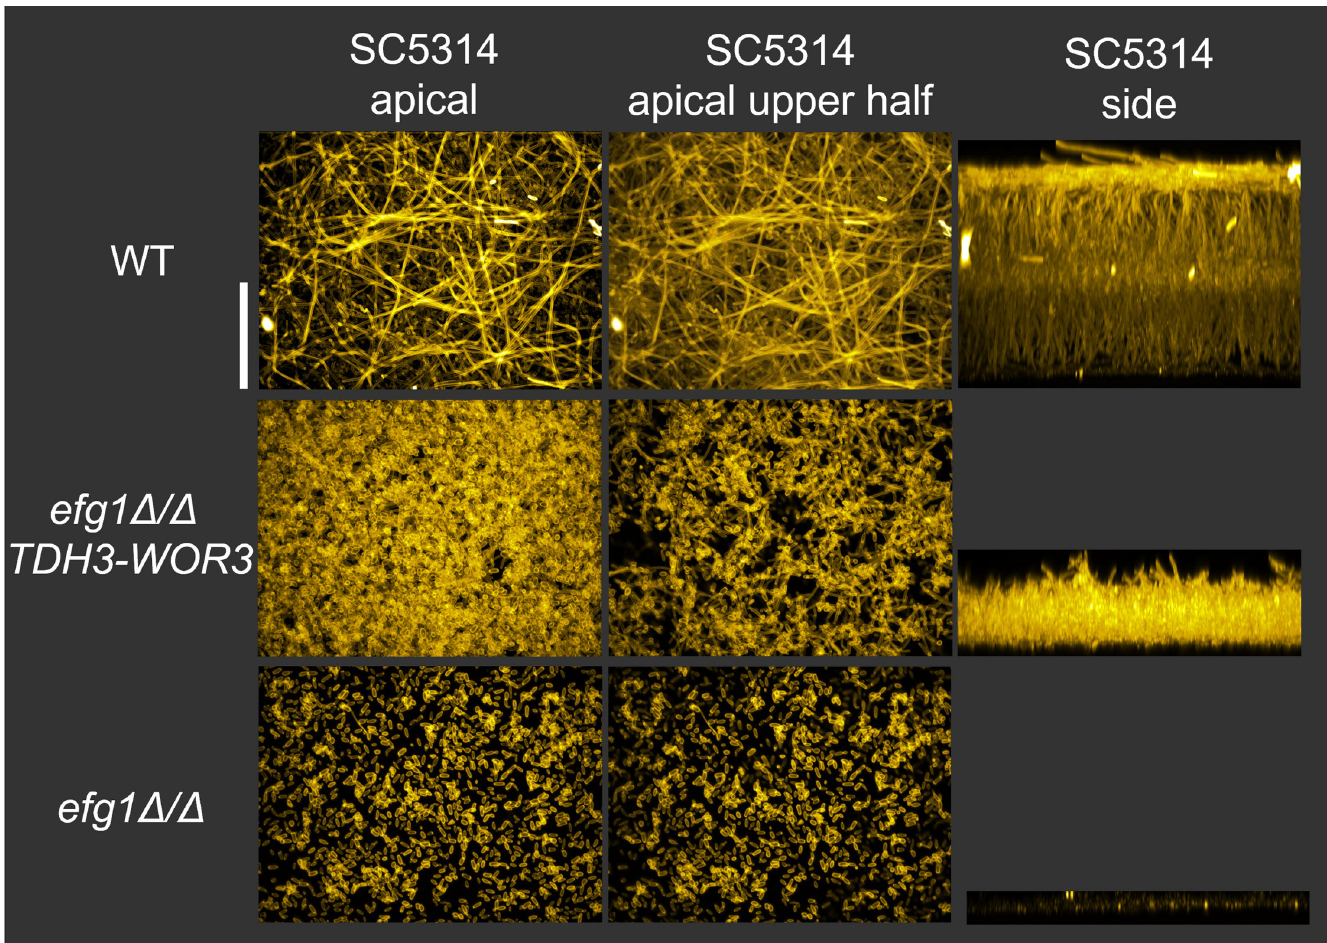
Fig 7. Imaging of TDH3-WOR3 biofilms in the SC5314 background. Biofilms were imaged after 24 hrs at 37˚C in RPMI+10% FBS for WT, efg1 Δ / Δ , and efg1 Δ / Δ TDH3-WOR3 SC5314-derived strains using the “Silicone substrate–confocal microscopy” method. Maximum intensity apical projections of the entire biofilm (Left column) and the top half of the biofilm (Middle column) were generated for each strain. Side view projections (Right column) were also generated. Scale bar indicates 60 μ